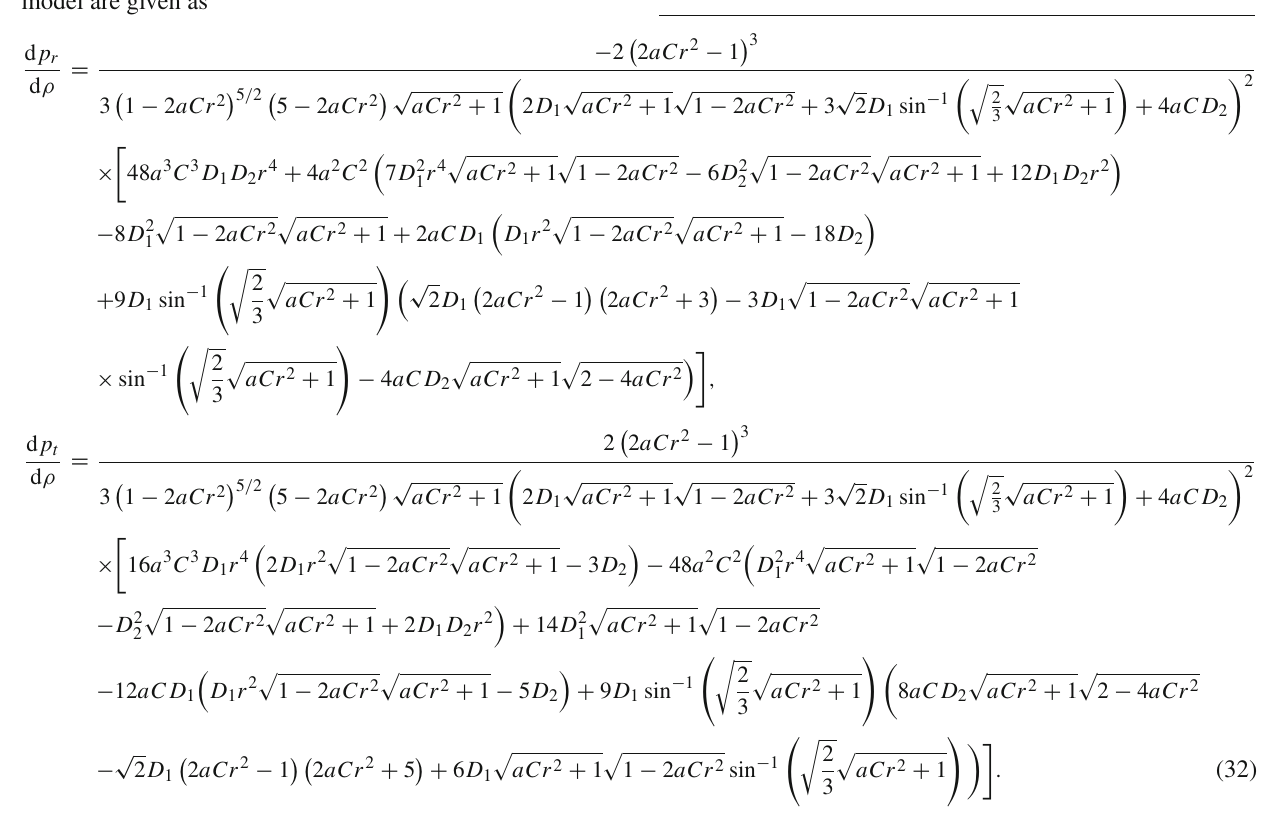
The causality condition for our model is shown in Fig. 8. Additionally, Abreu et al. [76] reintroduced a range for Her- rera’s cracking concept to determine the potentially stable (or unstable) anisotropic compact object. According to their study, a potentially stable model should follow the inequality within the stellar radius. The inequality − 1 ≤ v 2 also holds for our model, as shown in Fig.